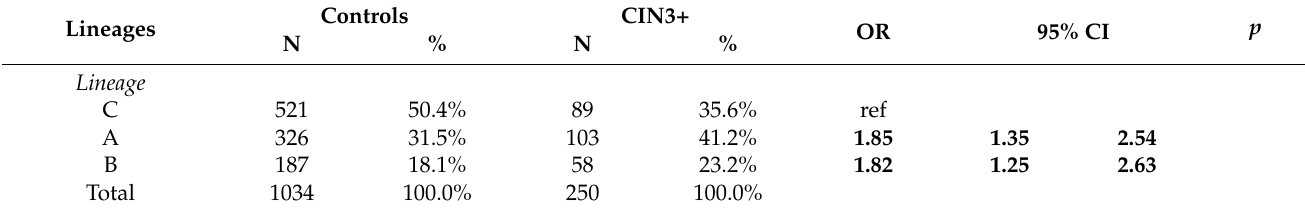
Table 1. HPV31 lineage associations with CIN3+, and effect modification of race/ethnicity, in the PaP cohort.